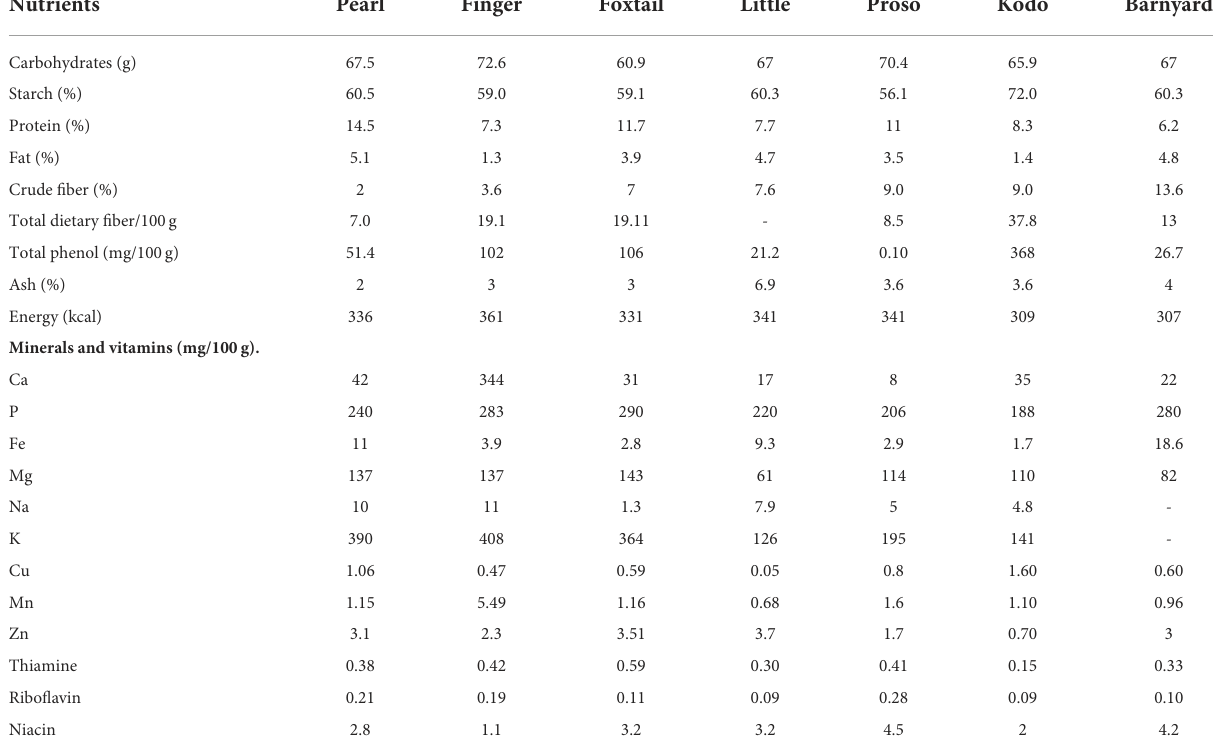
TABLE 1 Nutritional values of millets (per 100g edible portion, dry weight basis). Nutrients Pearl Finger Foxtail Little Proso Kodo Barnyard Carbohydrates